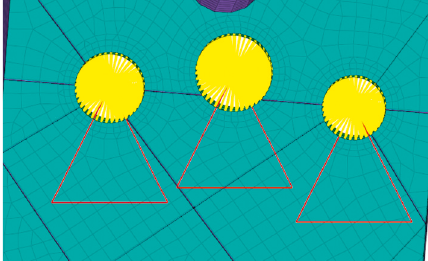
Figure 19: Boundary condition